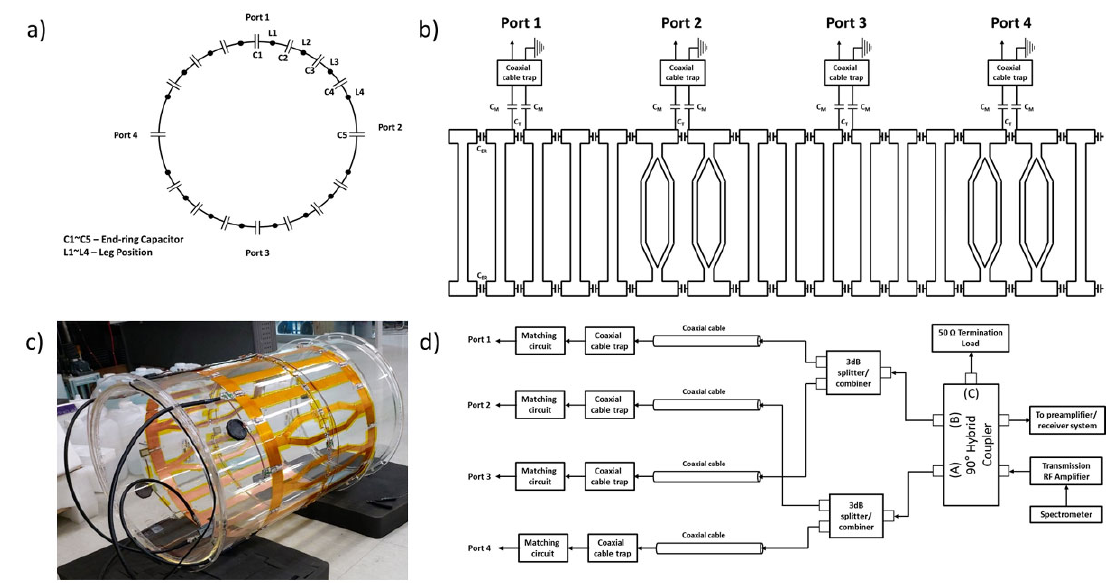
Figure 2. ( a ) Schematic illustration of split ‐ type elliptical birdcage showing positions of legs, capacitors, and ports; ( b ) unfolded view; detuning circuit is not shown for simplicity; ( c ) constructed split ‐ type elliptical birdcage; ( d ) implemented setup for transmission and reception at 1.5 T MRI.